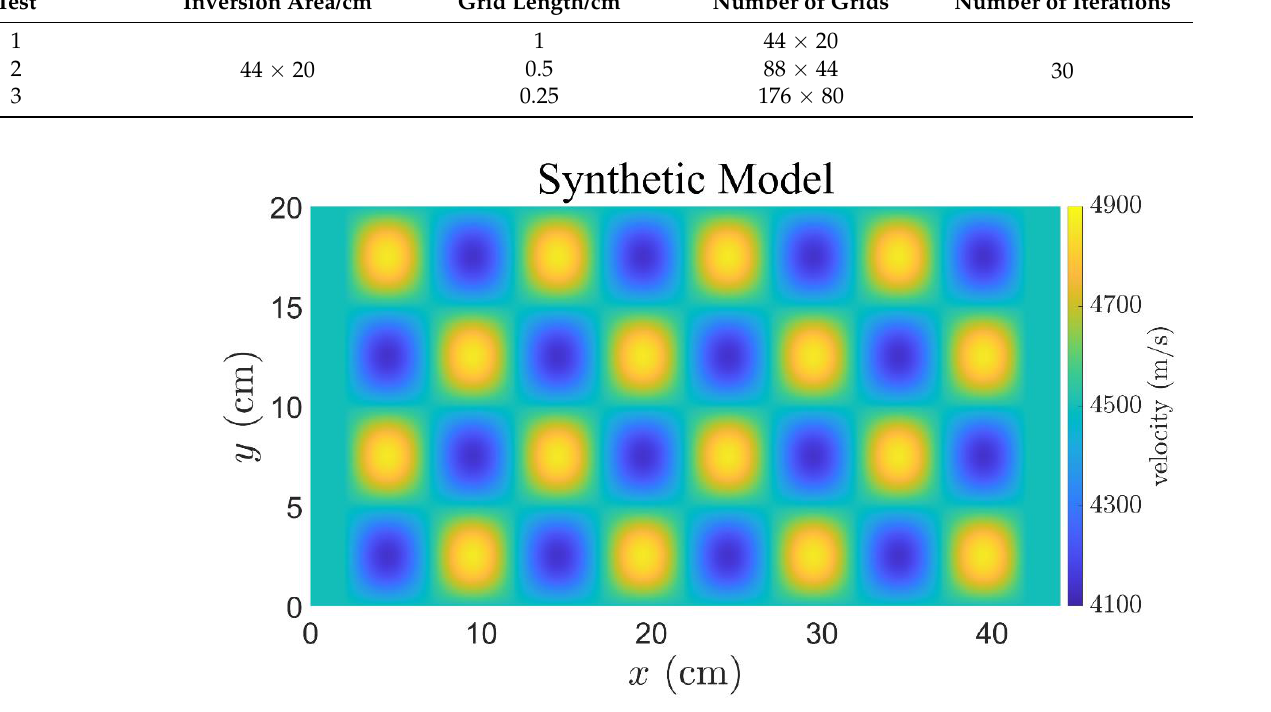
Figure 9. Synthetic checkerboard model for resolution tests.